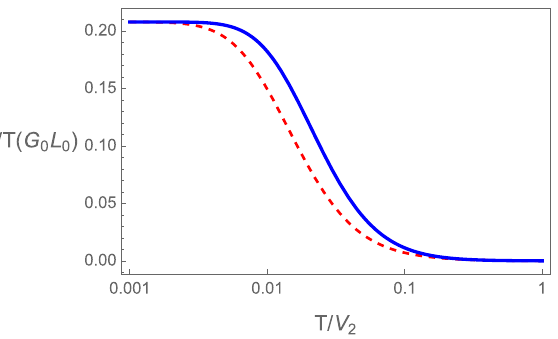
Figure 8. Thermal conductance divided by temperature of the device at the topological transition of the RM chains in units of G 0 L 0 , where L 0 is the Lorenz number for ǫ = 01 blue continuous, and ǫ = 0.3 red dashed. The zero temperature limiting value ( K / T ) 0 ≈ 0.20792 (see text). is independent of the values of t d and ǫ as long as, µ = ǫ and E 0 = 0 .